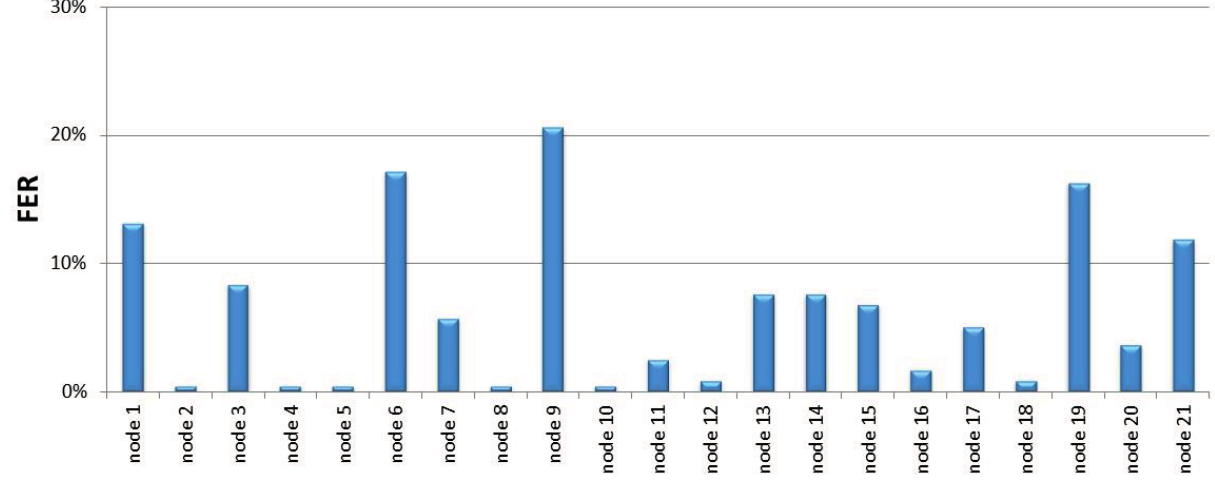
Figure 10. Frame Error Rate (FER) breakdown in 616 Bps ( j =